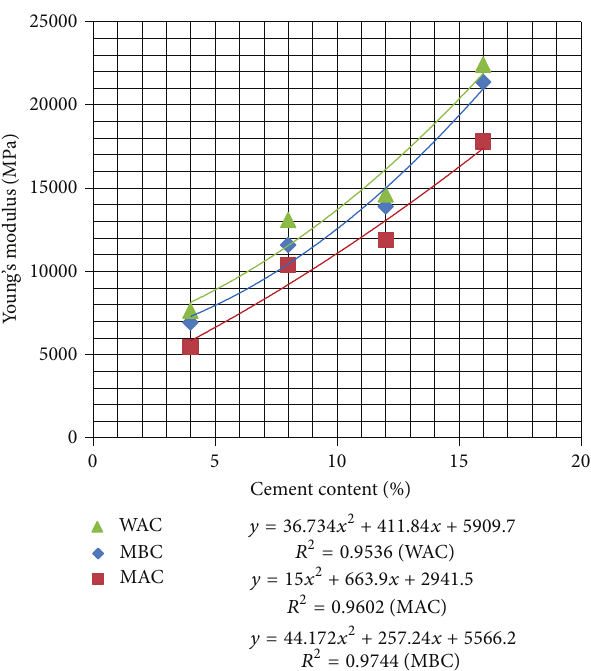
Figure 12: Young’s modulus of different cement contents (dry durability